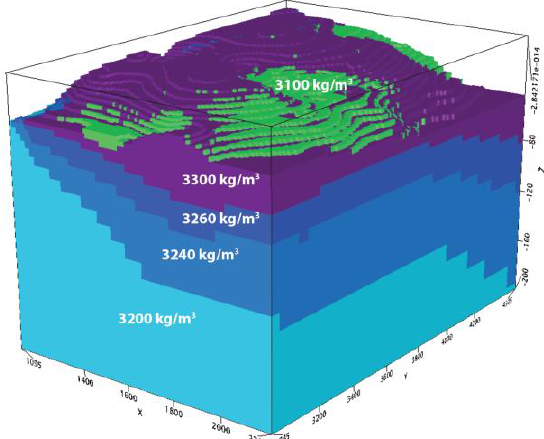
Figure 6: Voxel model in Geosoft. Colours indicate different density values. Voxel sizes are increasing with